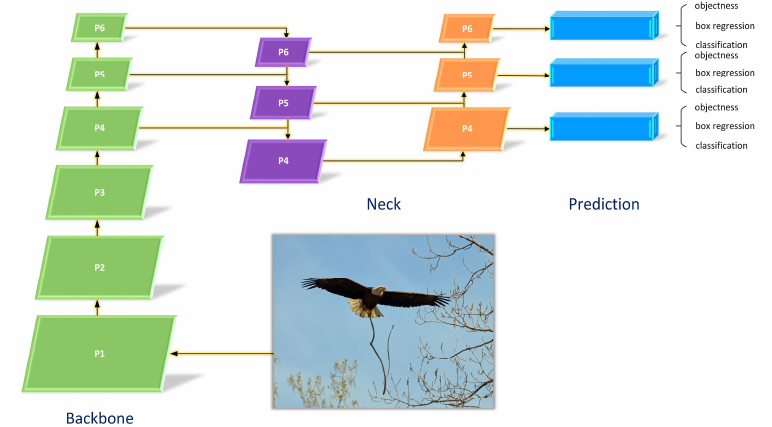
Figure 3. Network structure of the model.